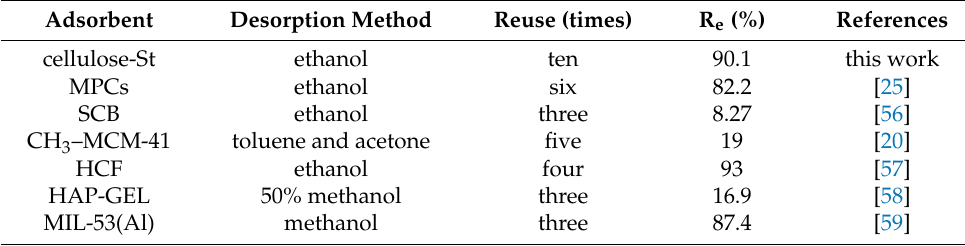
Figure 7. The reusability studies of cellulose-St. Table 4. Comparisons of reusability towards NB with other adsorbents